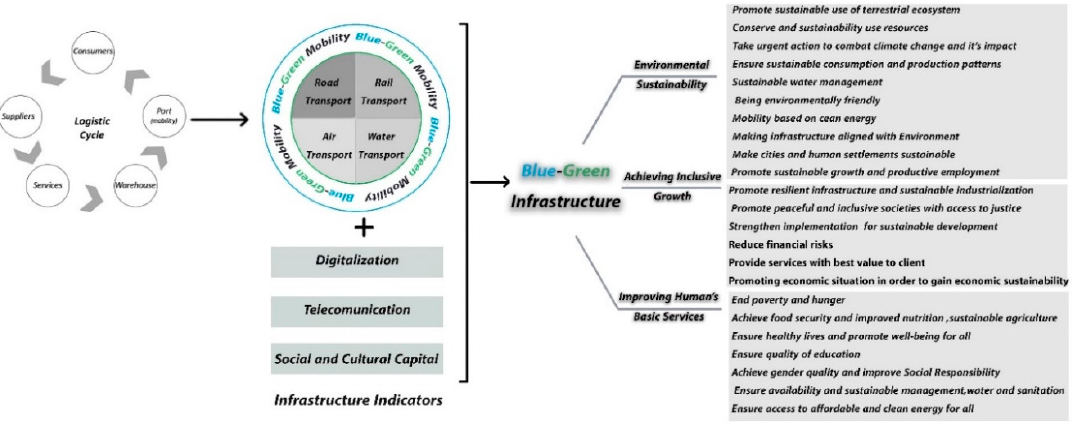
Figure 6. Mobility-BGI Theory.